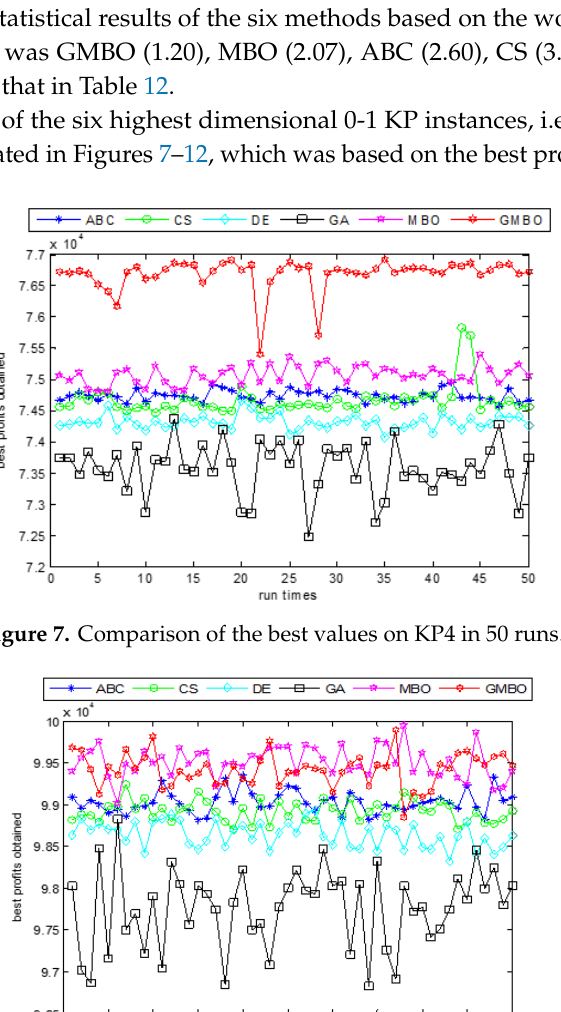
Figure 7. Comparison of the best values on KP4 in 50 runs.